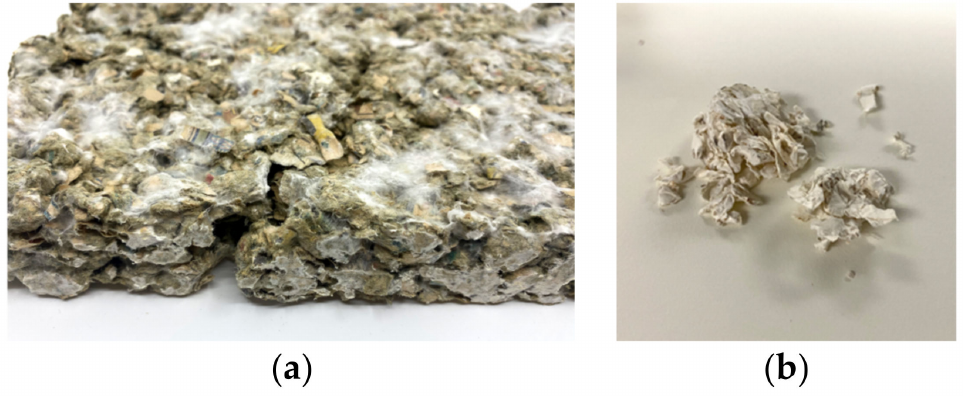
Figure 6. Structural Integrity of Mycelium Samples: ( a ) FNL ( b )